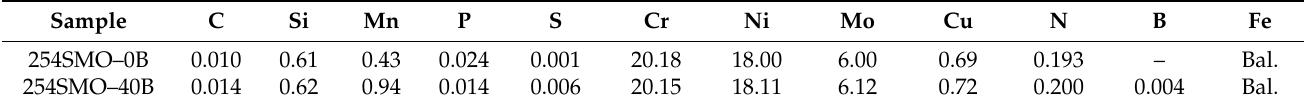
Table 1. Chemical composition of 254SMO SASSs